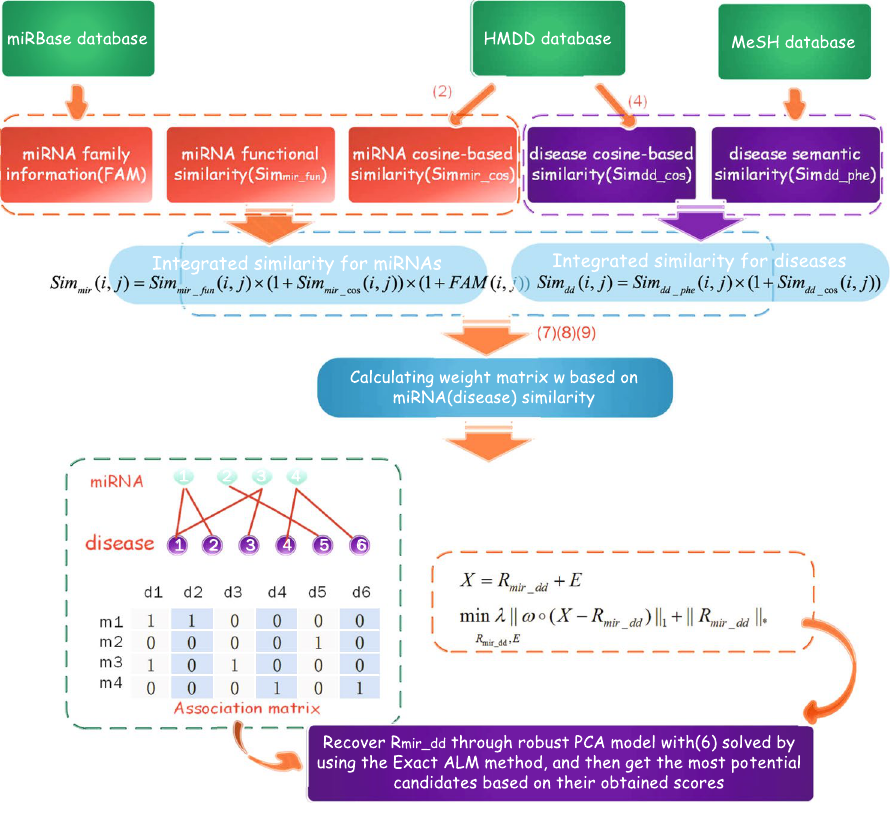
Figure 4. The overall flowchart of